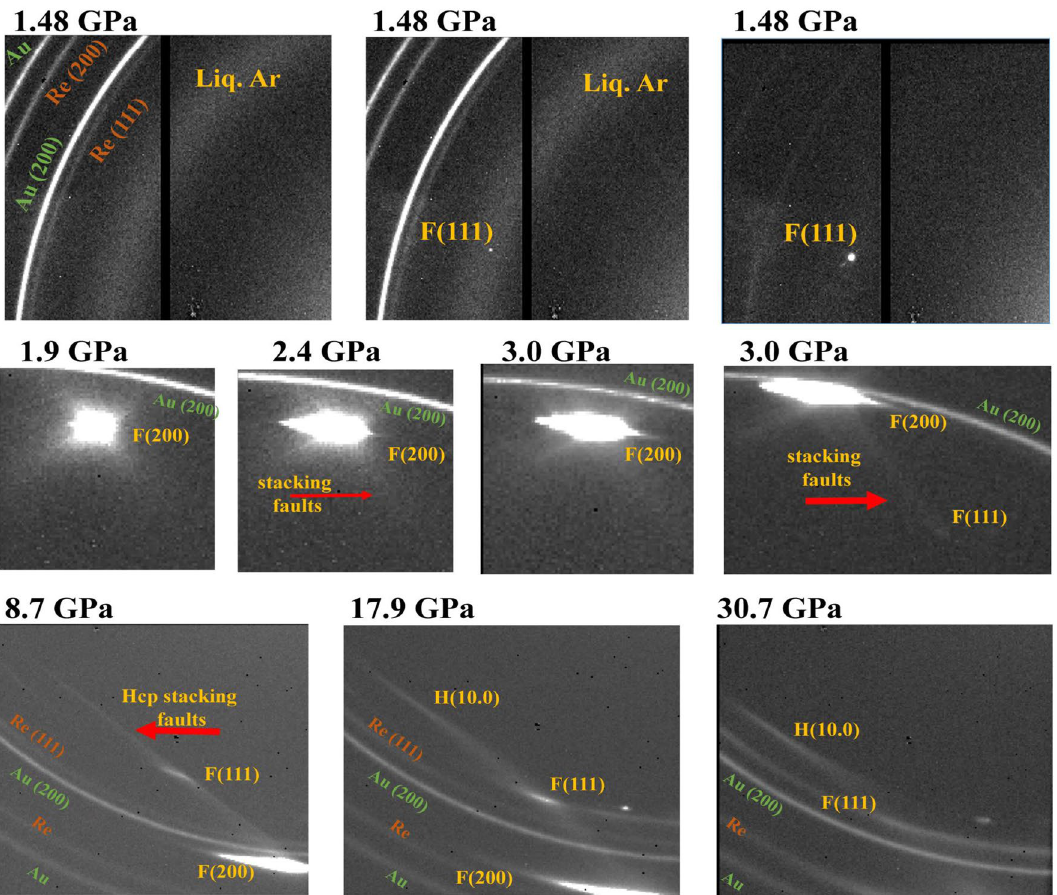
Figure 1. Textures in pure Ar from bidimensional X-ray diffraction images collected in run 1. At 1.48 GPa, Ar grows as a few single crystals from the melt. Evidences of non-hydrostatic compression—a broadening of single crystal XRD peaks—appear around 2.4 GPa. Stacking faults give rise to a structured diffuse signal above 1.9 GPa, which progressively transforms into (100) (labelled H(10.0)) and (101) hcp XRD